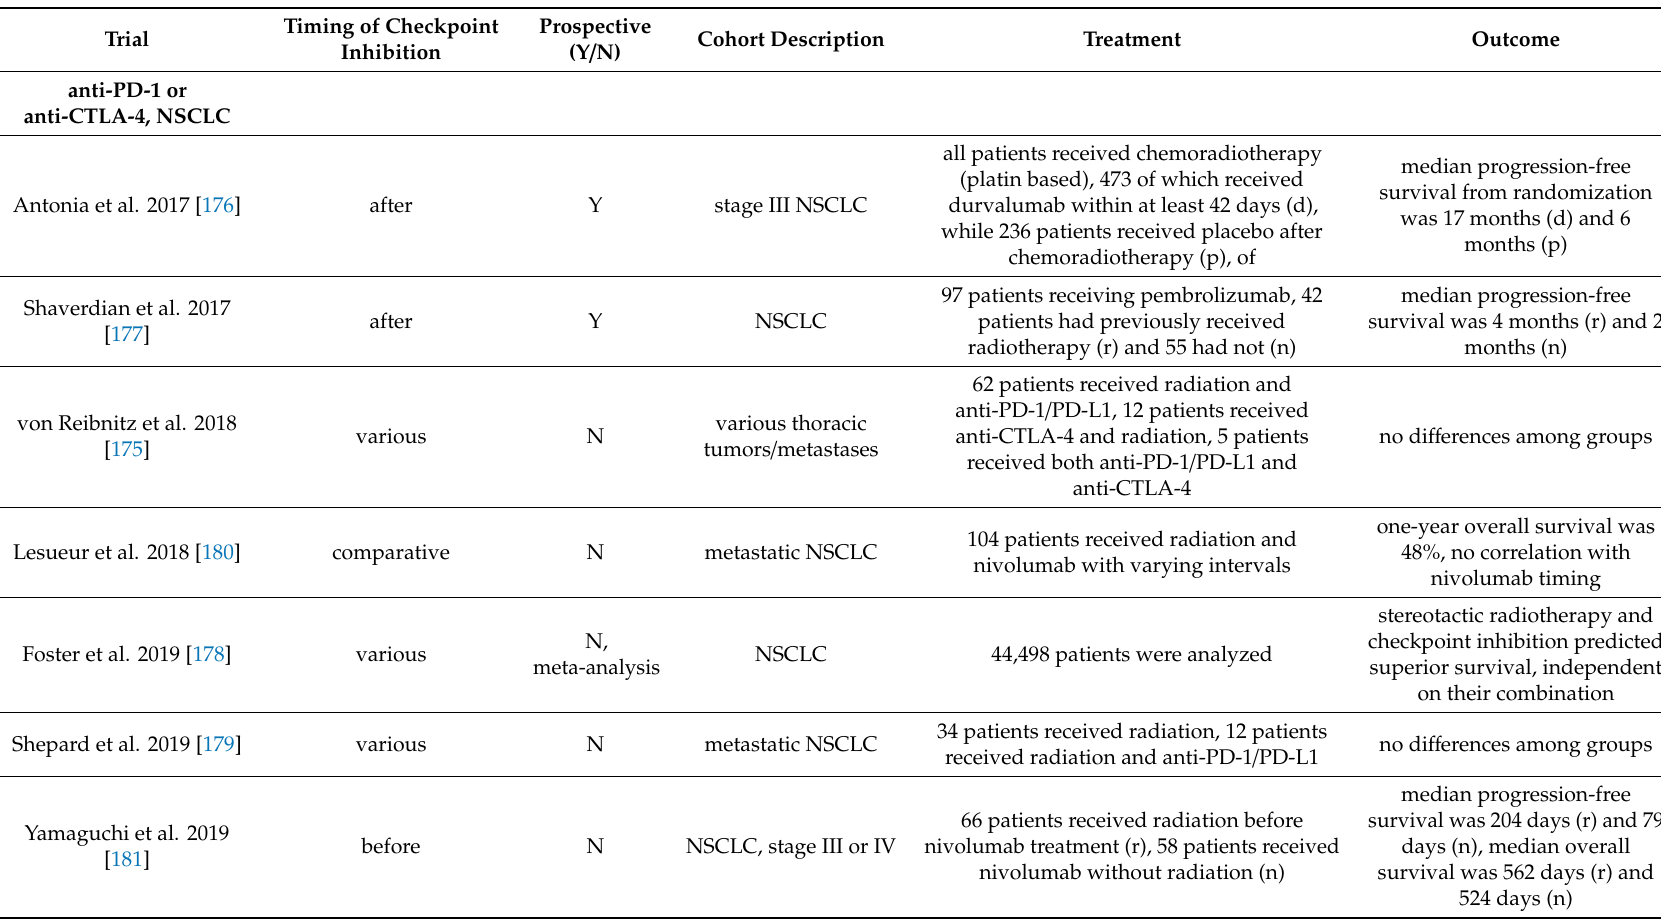
Table 5. Overview of clinical trials concerning combination of radiotherapy and anti-PD-1 or anti-CTLA-4 treatment in NSCLC and other thoracic malignancies. Clinical trials are sorted primarily by cancer and treatment setting, secondary criteria being chronological. Short descriptions of patient collective, treatment, and outcome are